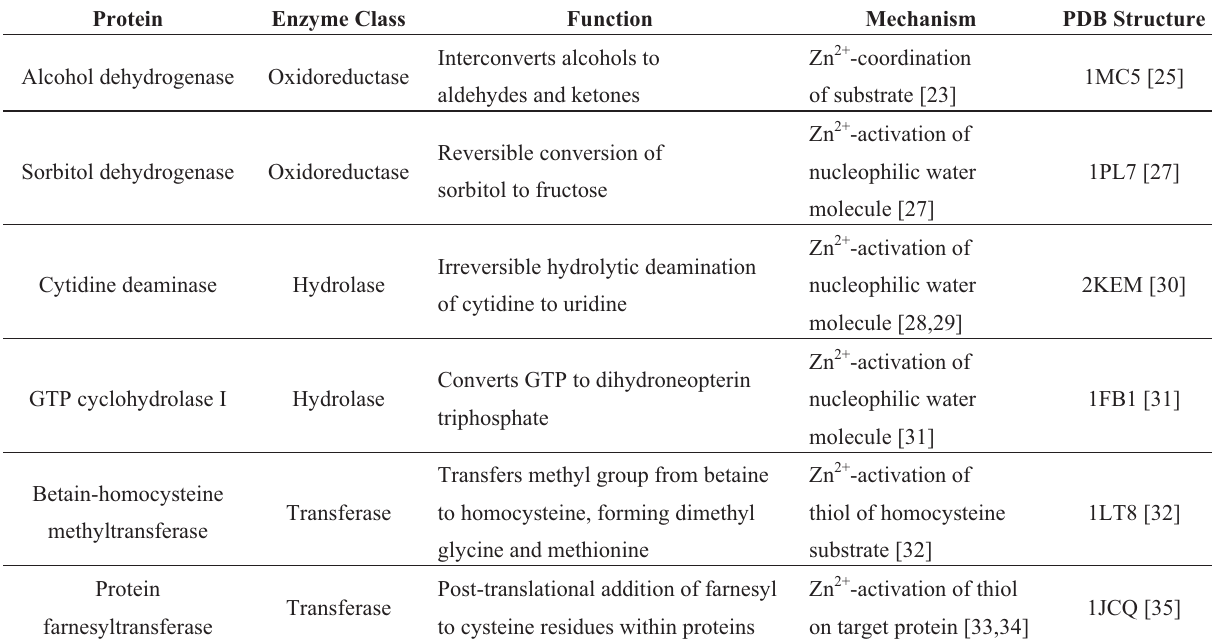
Table 1. Representative human proteins containing catalytic Zn 2+ -cysteine